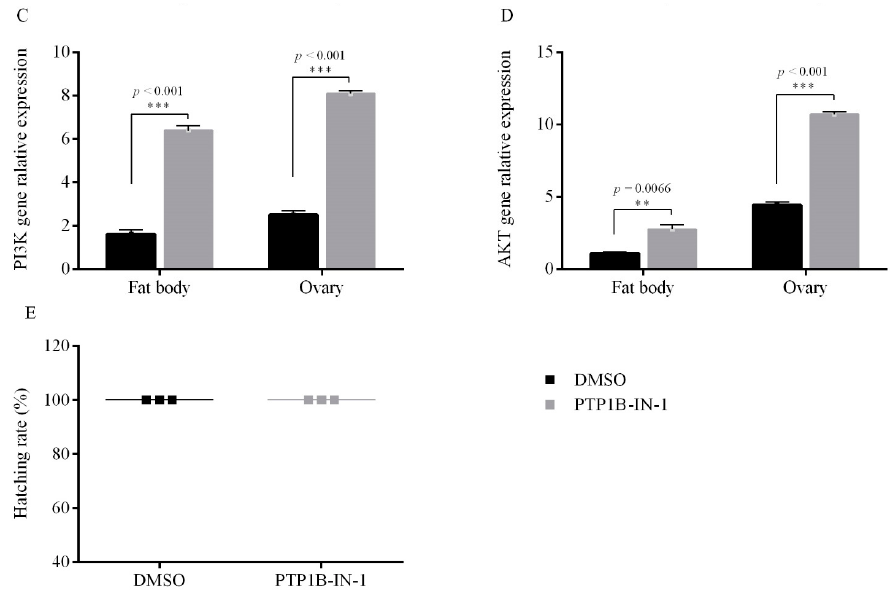
Figure A2. Gene relative expression, phosphorylation level, energy metabolism and egg hatching incidence after injection of adults with PTP1B inhibitor PTP1B-IN-1 compared to DMSO (control) under long photoperiod conditions (L16:D8). ( A ) IR gene, ( B ) IRS gene, ( C ) PI3K gene, ( D ) AKT gene, in the fat bodies and ovaries, ( E ) egg hatching incidence. Data are the mean ± SEM from three independent replicates, the gray bar indicates PTP1B inhibitor treatments, while the black bar indicates DMSO controls (** p < 0.01 and *** p < 0.001 vs. DMSO controls, Student’s t -test).